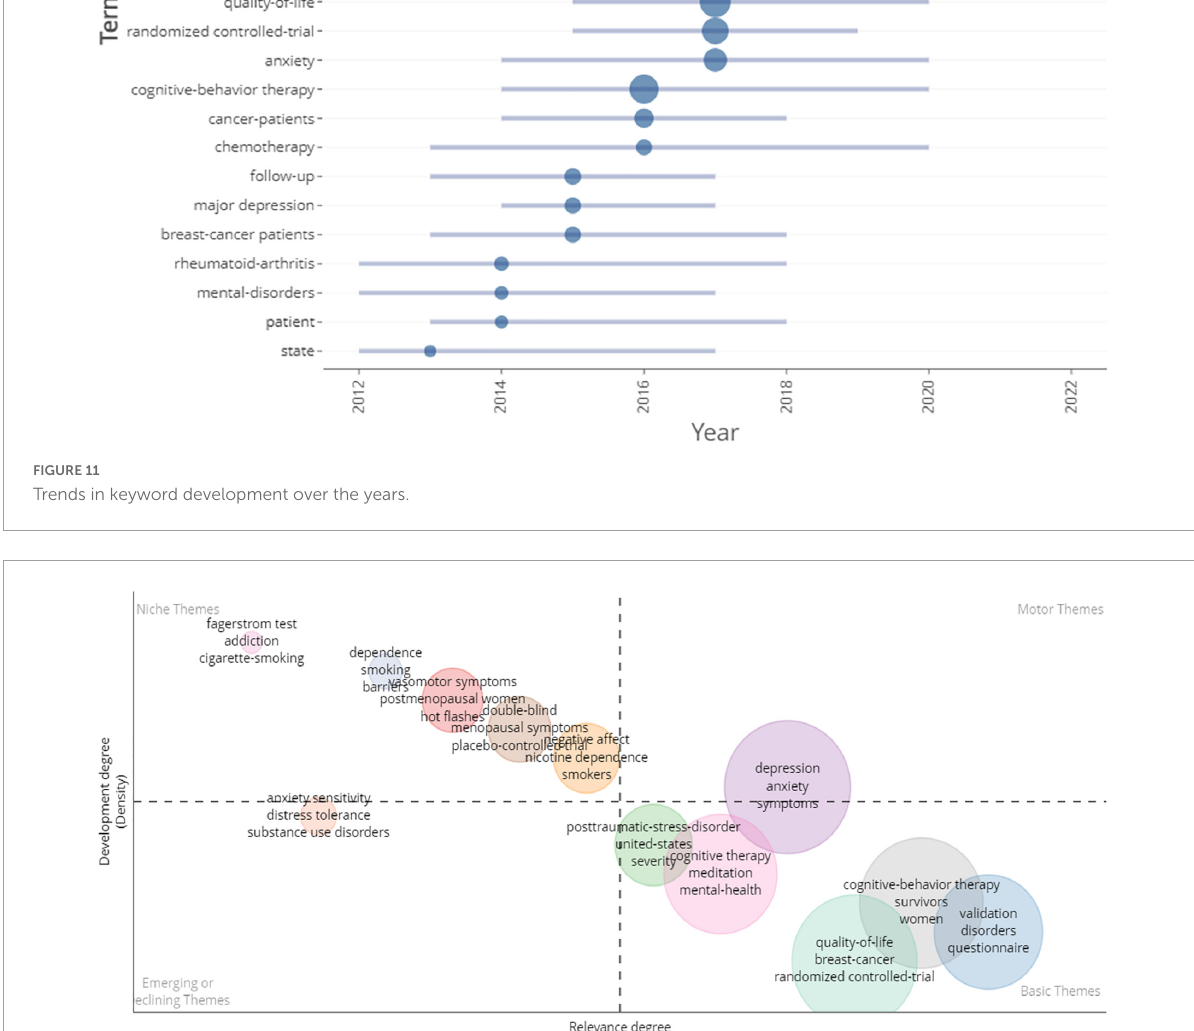
2015 and a downward trend after 2015. This may be related